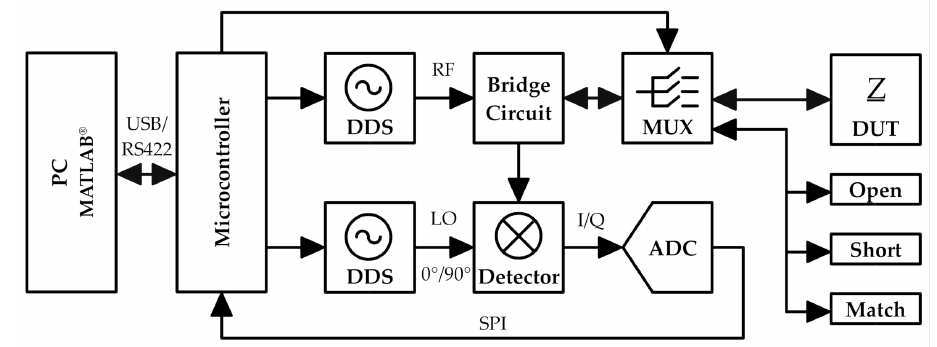
Figure 8. Scheme of the functional blocks of the measurement